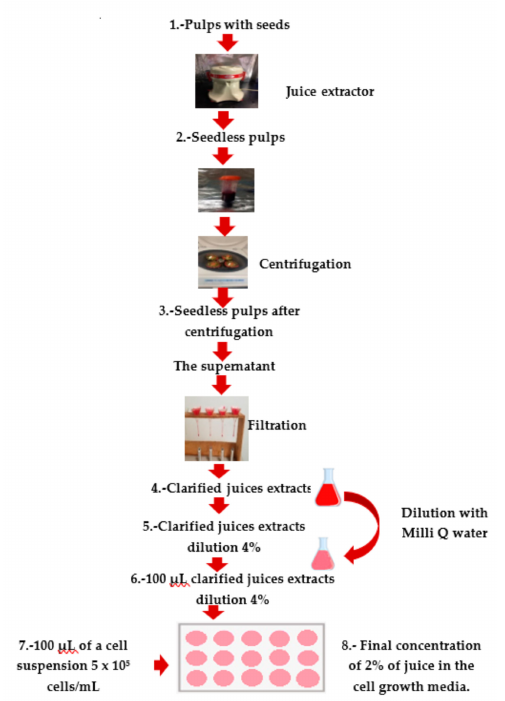
Figure A1. Dilution of clarified juice